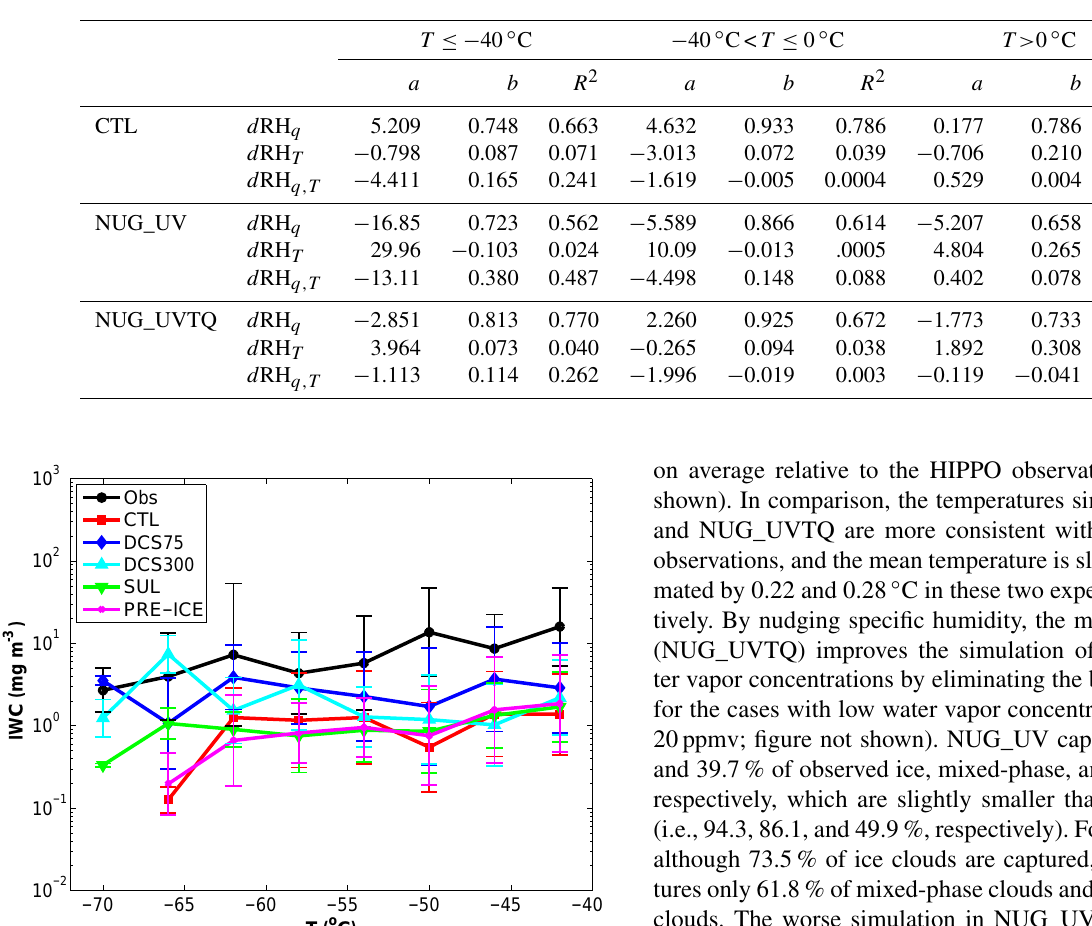
Table 3. The intercepts and slopes of the regression lines (i.e., Y = a + b × X) for d RH q versus d RH, d RH T versus d RH, and d RH q,T versus d RH in the three experiments CTL, NUG_UV, and NUG_UVTQ, respectively. The coefficients of determination (i.e., R 2 ) for each regression line are also presented.